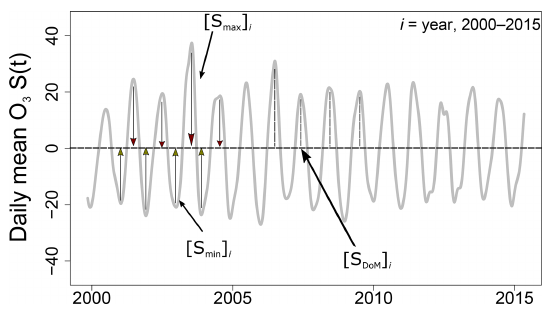
Figure 2. Schematic illustration for explaining the estimation of the ( S max (t) and S min (t) ) and the annual day of maximum of the sea- sonal signal ( S DoM (t) ) as calculated from the daily mean O 3 time